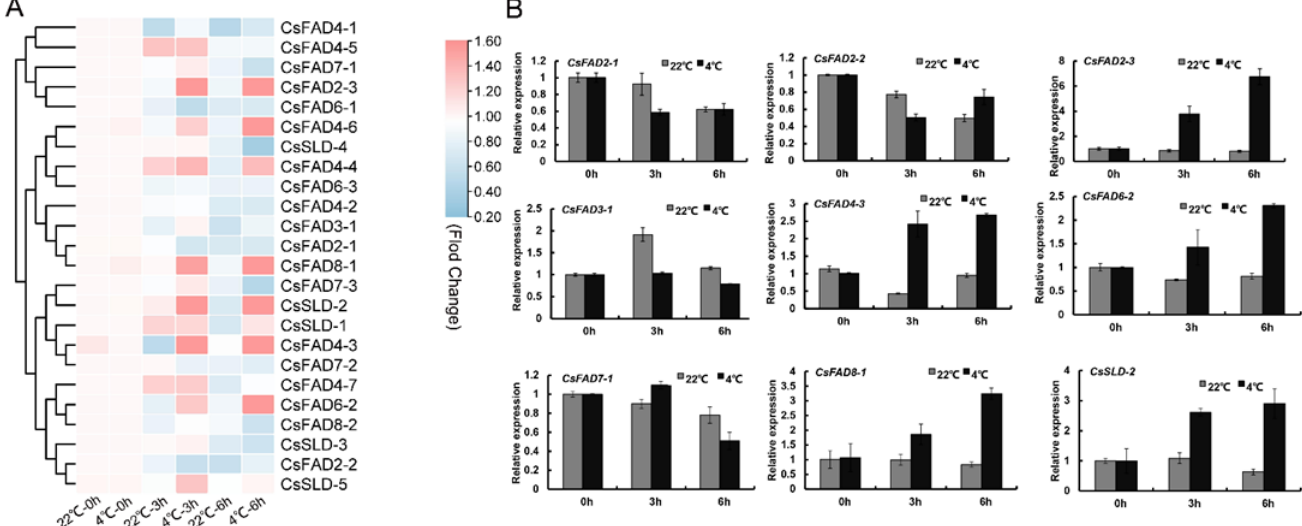
Figure 5. Expression patterns of CsFAD genes in Camelina during low-temperature stress: ( A ) nor- malized expression levels of CsFAD genes in Camelina during low-temperature stress. qRT-PCR was used to investigate the expression levels of the CsFAD genes during low-temperature stress. Log2 fold change for low-temperature treatment was used to present expression change under low-temperature treatment. Expression levels are illustrated by graded color scale from green to red; ( B ) qRT-PCR profiles of CsFAD genes during low-temperature treatment. The low-temperature (4 °C) treatment lasted 0 h, 3 h, and 6 h. The expression level of CsFADs in control was normalized as “1”. Vertical bars indicate the standard error of the mean. Data are shown as means ± SD of three replicates (n = 3 × 3).